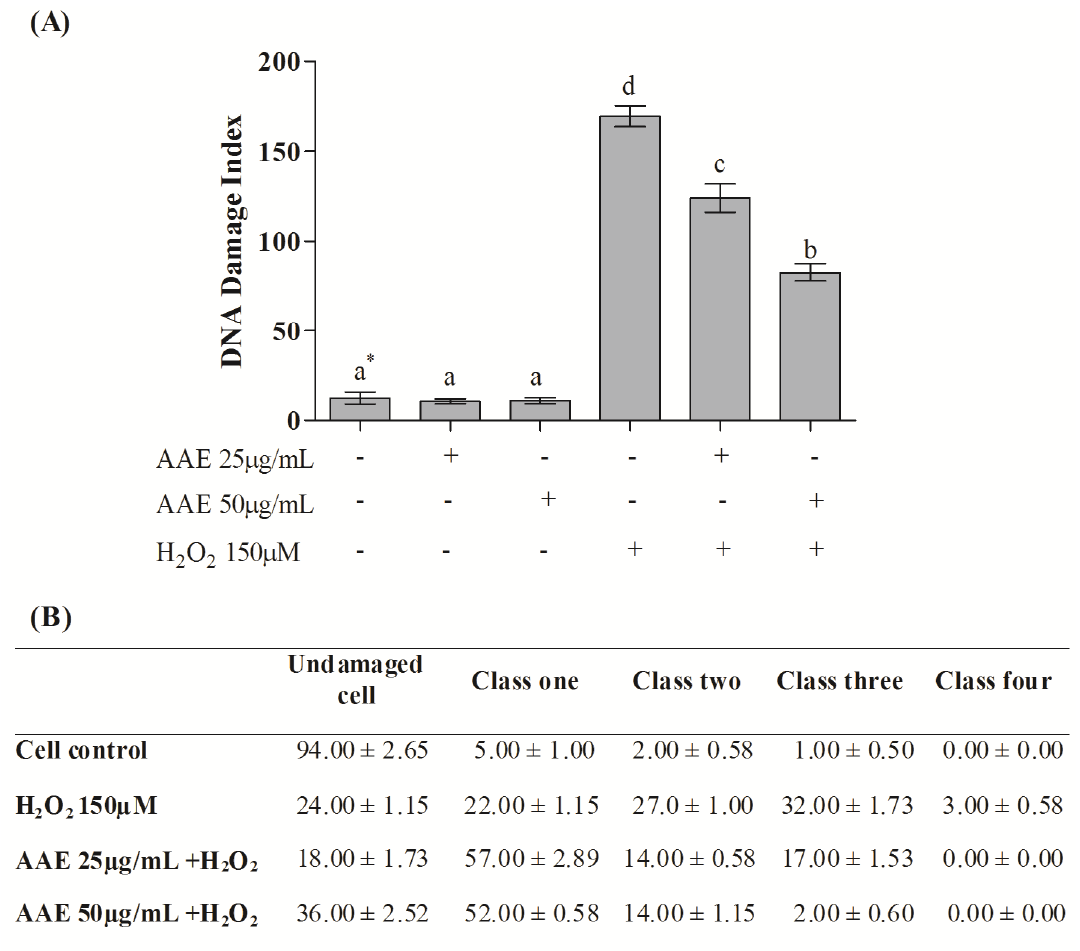
Figure 3. ( A ) DNA damage index by the alkaline Comet assay in MRC5 cells after treatment with AAE and exposure to H O . * Different letters indicate significant 2 2 differences by analysis of variance (ANOVA) and Tukey’s post-hoc test ( p ≤ 0.05). ( B ) Frequency (%) of different classes of DNA damage in control and AAE-treated groups. The cells were assessed visually and received scores from 0 (no injury) to 4 (maximally damaged), according to the size and shape of the tail. Data are mean ± SD values.